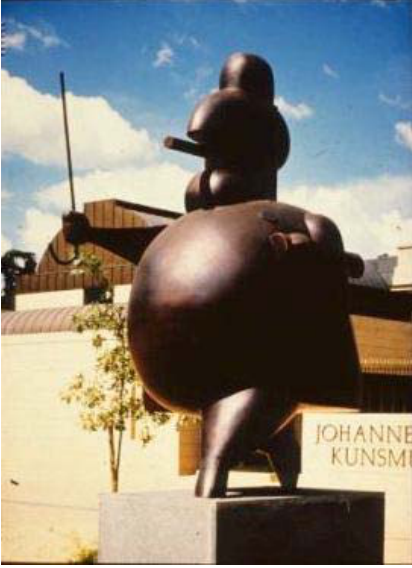
Figure 5. Bruce Arnott’s Citizen (1985–86) in the forecourt of the Johannesburg Art Gallery (author’s